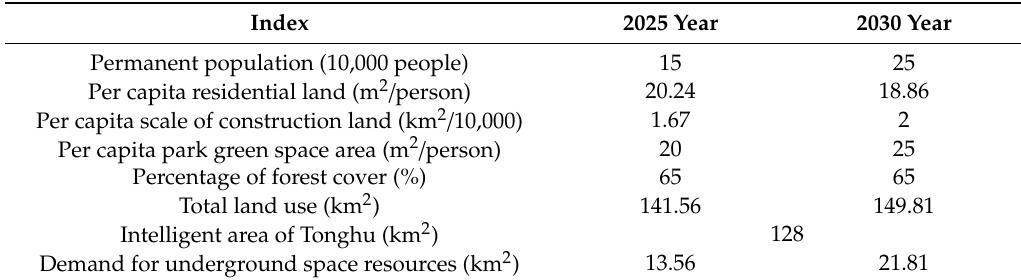
Table 10. Table forecasting the underground space demand in the research